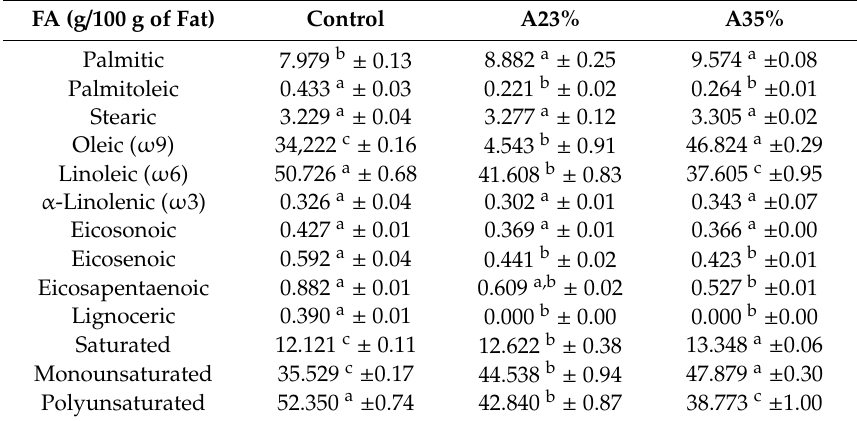
Table 3. Fatty acids profile of GFB with the incorporation of di ff erent ratios of acorn flour (A23% and A35%) and comparison with control samples.